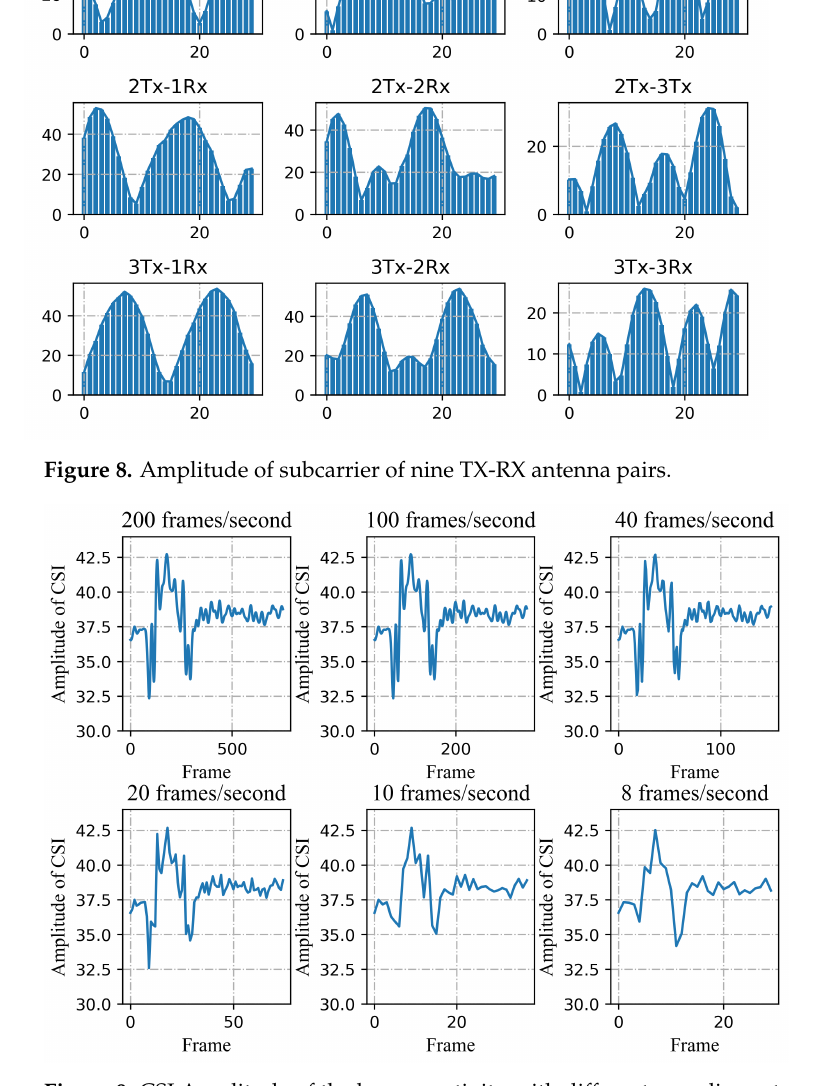
Figure 9. CSI Amplitude of the human activity with different sampling